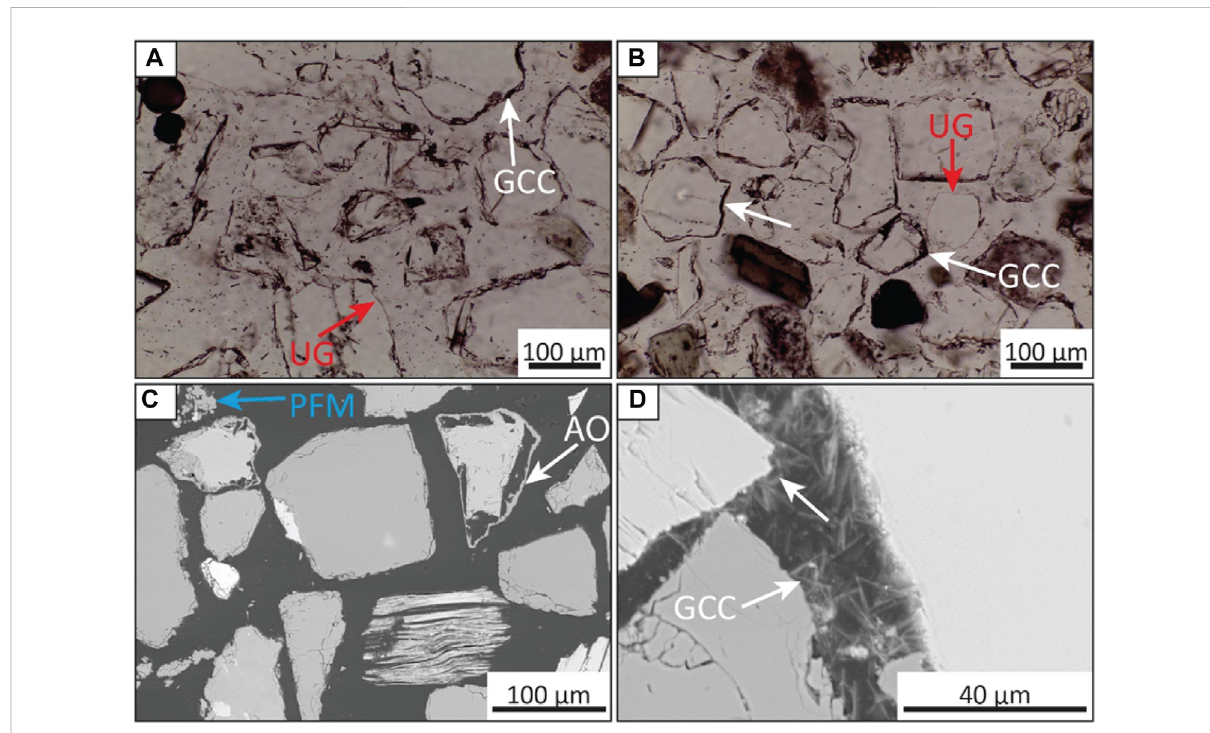
FIGURE 5 Thin-section photomicrographs and BSE images of the reacted samples from Station 028A. (A,B) Photomicrographs of the reacted Sample 3 showing uncoated grains (UG) and generally discontinuous grain-coating chlorite (GCC). (C) BSE image showing an albite overgrowth (AO) and pore- fi lling microcrystalline (PFM) in the silica-reacted Sample 2. (D) BSE image showing grain-coating chlorite (GCC) growing perpendicular to grain surfaces, into the pore and occluding intergranular porosity in the reacted Sample 3. (BSE, Backscattered